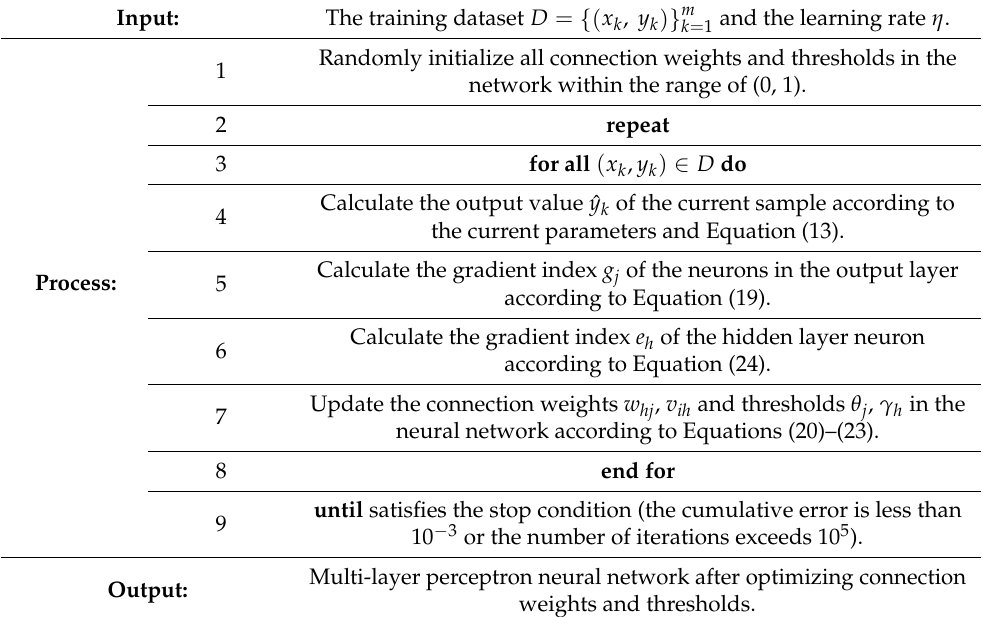
Table 3. The working flow chart of the error back propagation algorithm used in this